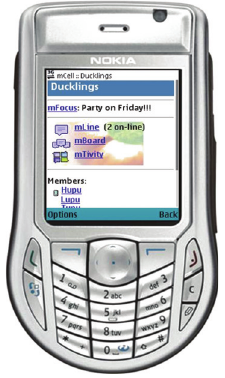
Figure 1: mCell UI main